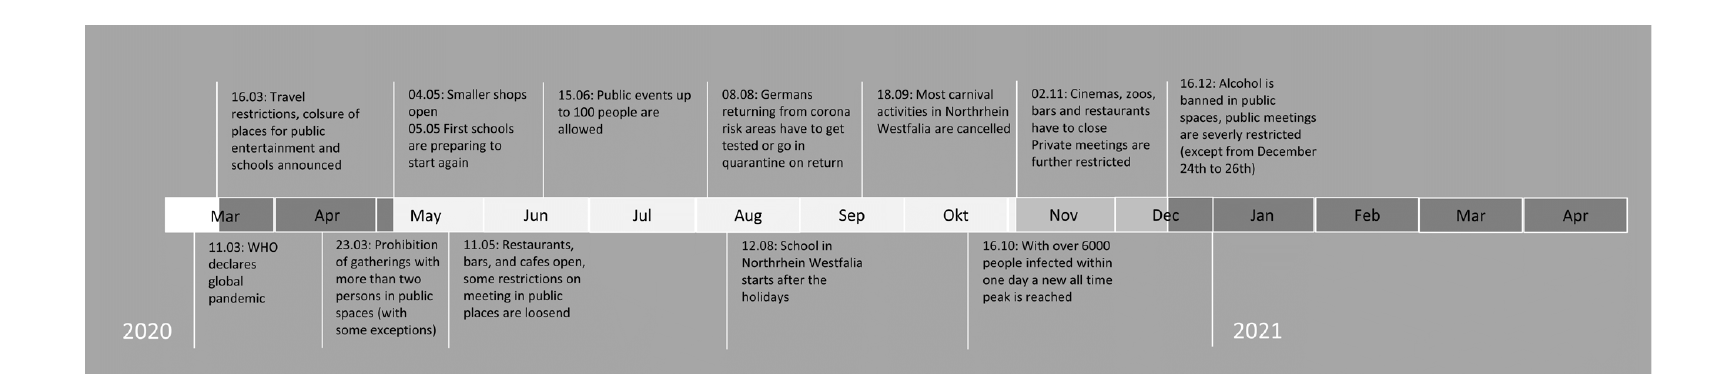
Figure A3. Overview of important measures and announcements, which affected the public life in Bochum. Lockdown phases were separated into ‘first lockdown’ (16 December 2020–28 April 2021). Full-on lockdowns are depicted dark grey, the lockdown light in a light grey, opening period in a bright grey, and pre-lockdown times in white. For detailed measures and references for each date see: 11.03 [59]; 16.03 [33–35]; 23.03 [52]; 04.05 [36]; 05.05 [37]; 11.05 [60]; 15.06 [61]; 08.08 [62]; 12.08 [63]; 18.09 [64]; 16.10 [65]; 02.11 [38]; 16.12 [39].